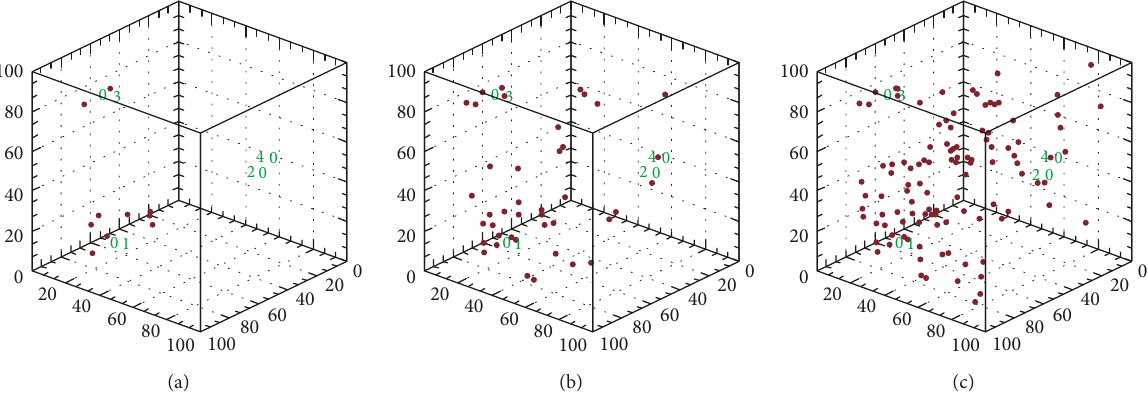
Figure 11: Characteristics of the AE events with 50% waste concrete substitution under uniaxial loading. (a–c) correspond to 0- σ and σ c - σ d of the stress stage in Figure